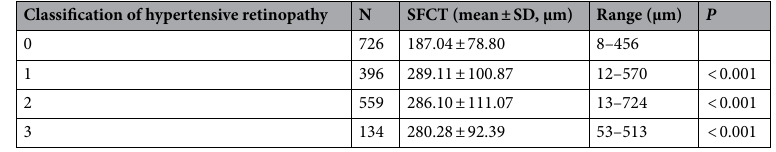
Table 1. SFCT in different classification of hypertensive